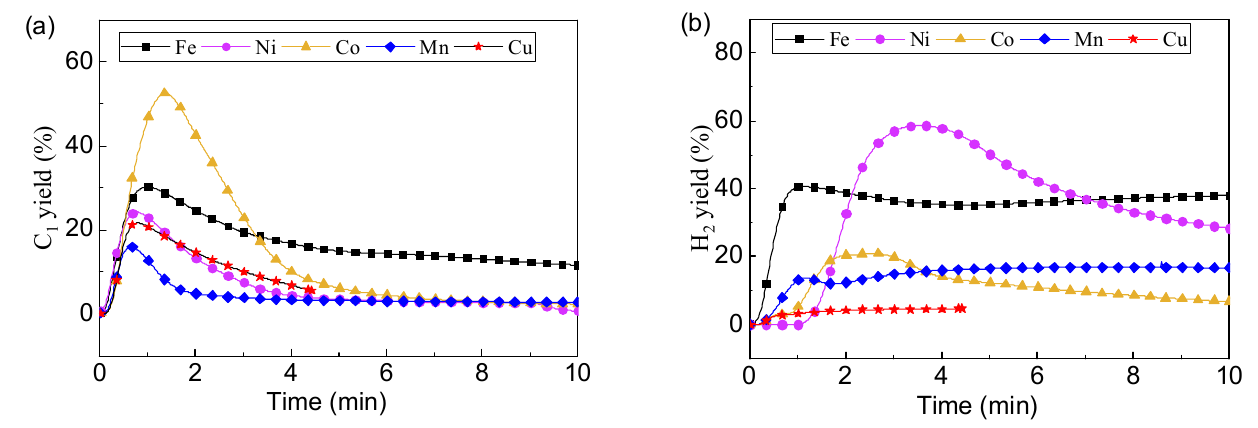
Figure 5. Chemical looping toluene conversion at 900 °C: ( a ) C 1 yield and ( b ) H 2 yield. Overall, under a different mechanism, LaFe and LaNi caused the most yield of H 2